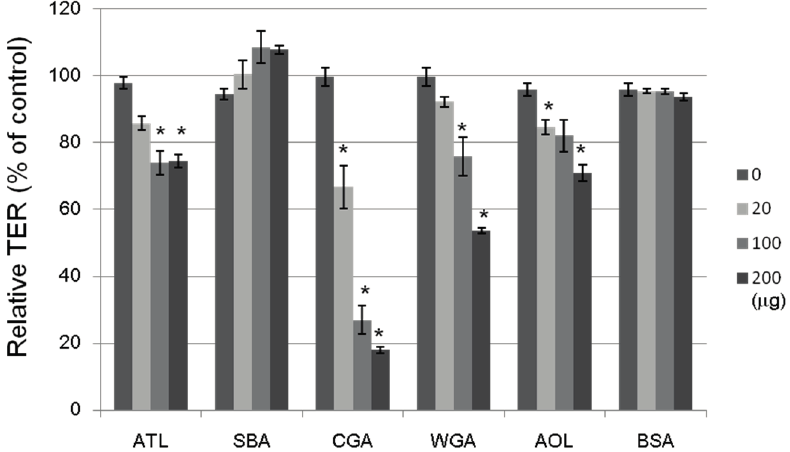
Figure 8. Effects of lectins on the TER values of Caco-2 monolayers. The cell monolayer TER value was measured after incubating for 2 h with a lectin (20–200 μ g/mL). ATL: Apios tuber lectin, SBA: Soybean lectin, CGA: Japanese jack bean lectin, WGA: Wheat germ lectin, and AOL: Aspergillus oryzae lectin. Bovine serum albumin (BSA) (20–200 μ g/mL) was used as a reference. Results are expressed as the percentage of the control value without a lectin at 0 h, and are the mean ± S.D. of three different determinations. * p < 0.05, compared with the control